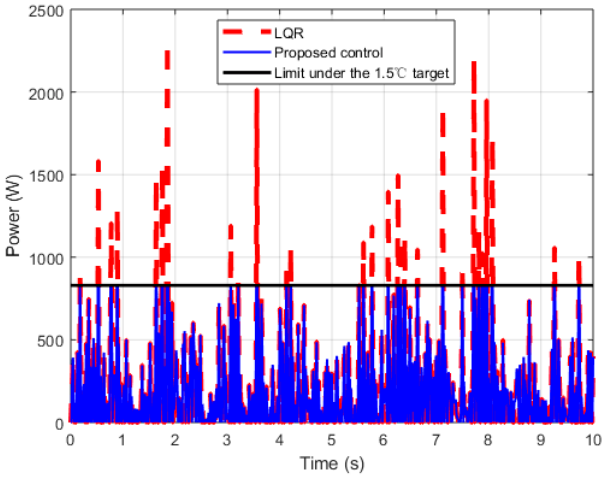
Figure 5. Power consumption comparison between the proposed control and the LQR.